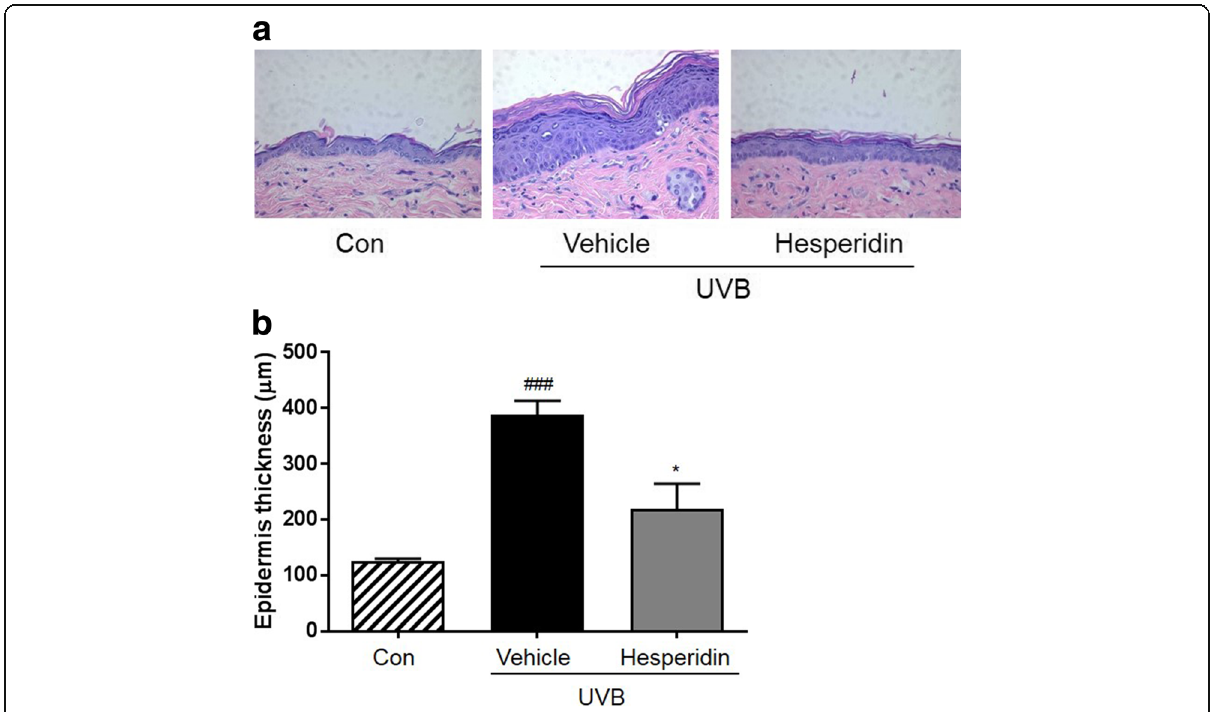
Fig. 3 Effect of hesperidin on the UVB irradiation-induced epidermal thickening in hairless mice dorsal skin. ( a ) Hematoxylin- and eosin-stained images of UVB-irradiated mice skin. Images are representative of results from 5 tissue samples. ( b ) Hesperidin improved the UVB-induced increase in epidermal thickness. ### P < 0.001 significant difference from control and * P < 0.05 significant difference from UVB/vehicle